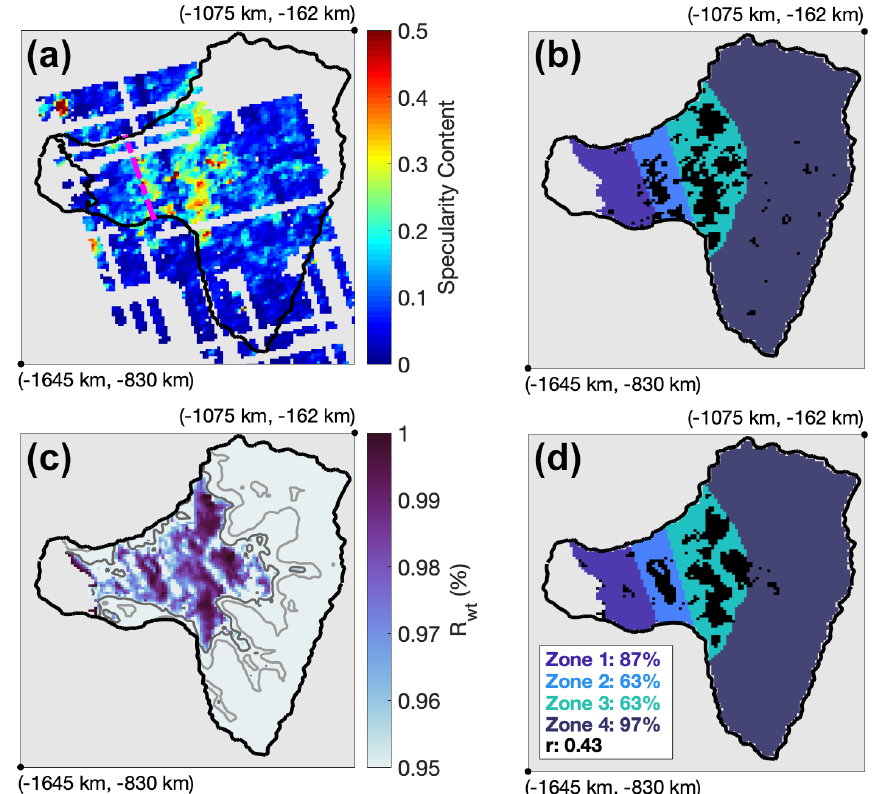
Figure 3. An example comparison of catchment-scale features identified with binary masks (black) of observed specularity content and modeled R wt . (a) Radar specularity content (Schroeder et al., 2013) and (c) R wt for a data-compatible flux steady-state model run, together with their coinciding binary masks, (b) S crt = 0 . 19 and (d) R crt wt = 0 . 98, respectively. The dashed pink line in (a) marks the transition between highly specular, distributed drainage, and channel-dominated drainage, as hypothesized in Schroeder et al. (2013). The four zones used for comparison between specularity content and R wt are color-coded in (b) and (d) . Light and dark gray lines in (c) are the 50% and 90% R wt contours, respectively. The percent match between masks within each zone and the overall correlation are given in (d) . The locations of map corners are given in Standard Antarctic Polar Stereographic